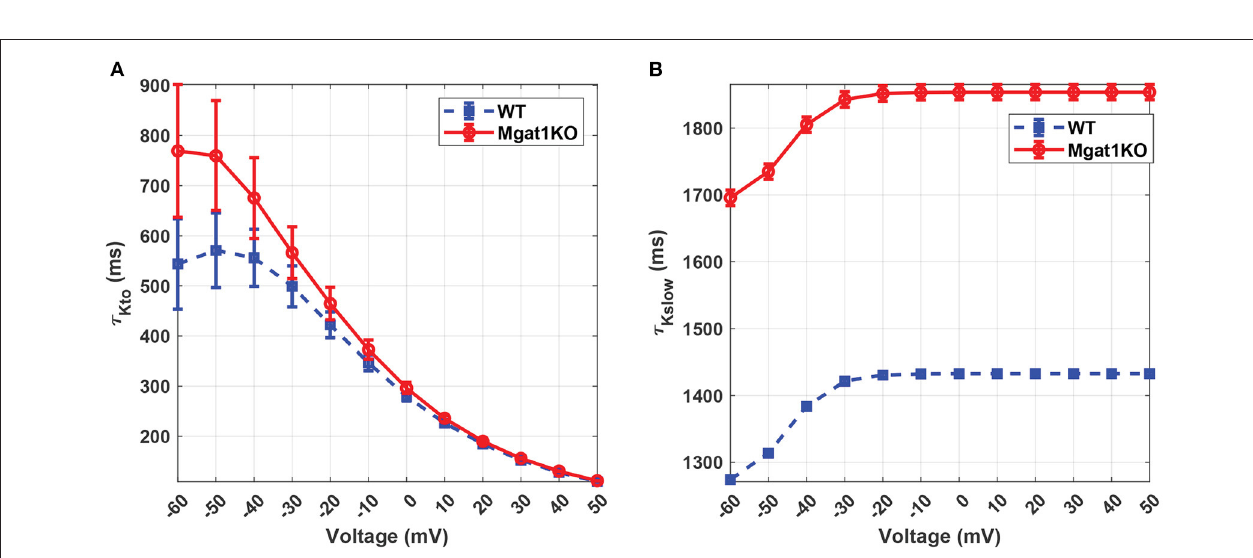
FIGURE 6 | Predicted current density to voltage relationship under the WT and Mgat1KO conditions. (A) I Kto . (B) I Kslow . Voltage steps range from -60 to 50 mV by 10-mV increments.